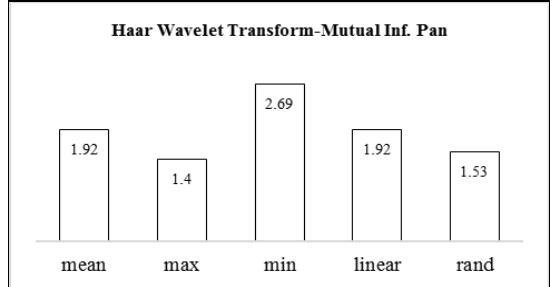
Figure 6. Mutual Information with respect to PAN for different filters